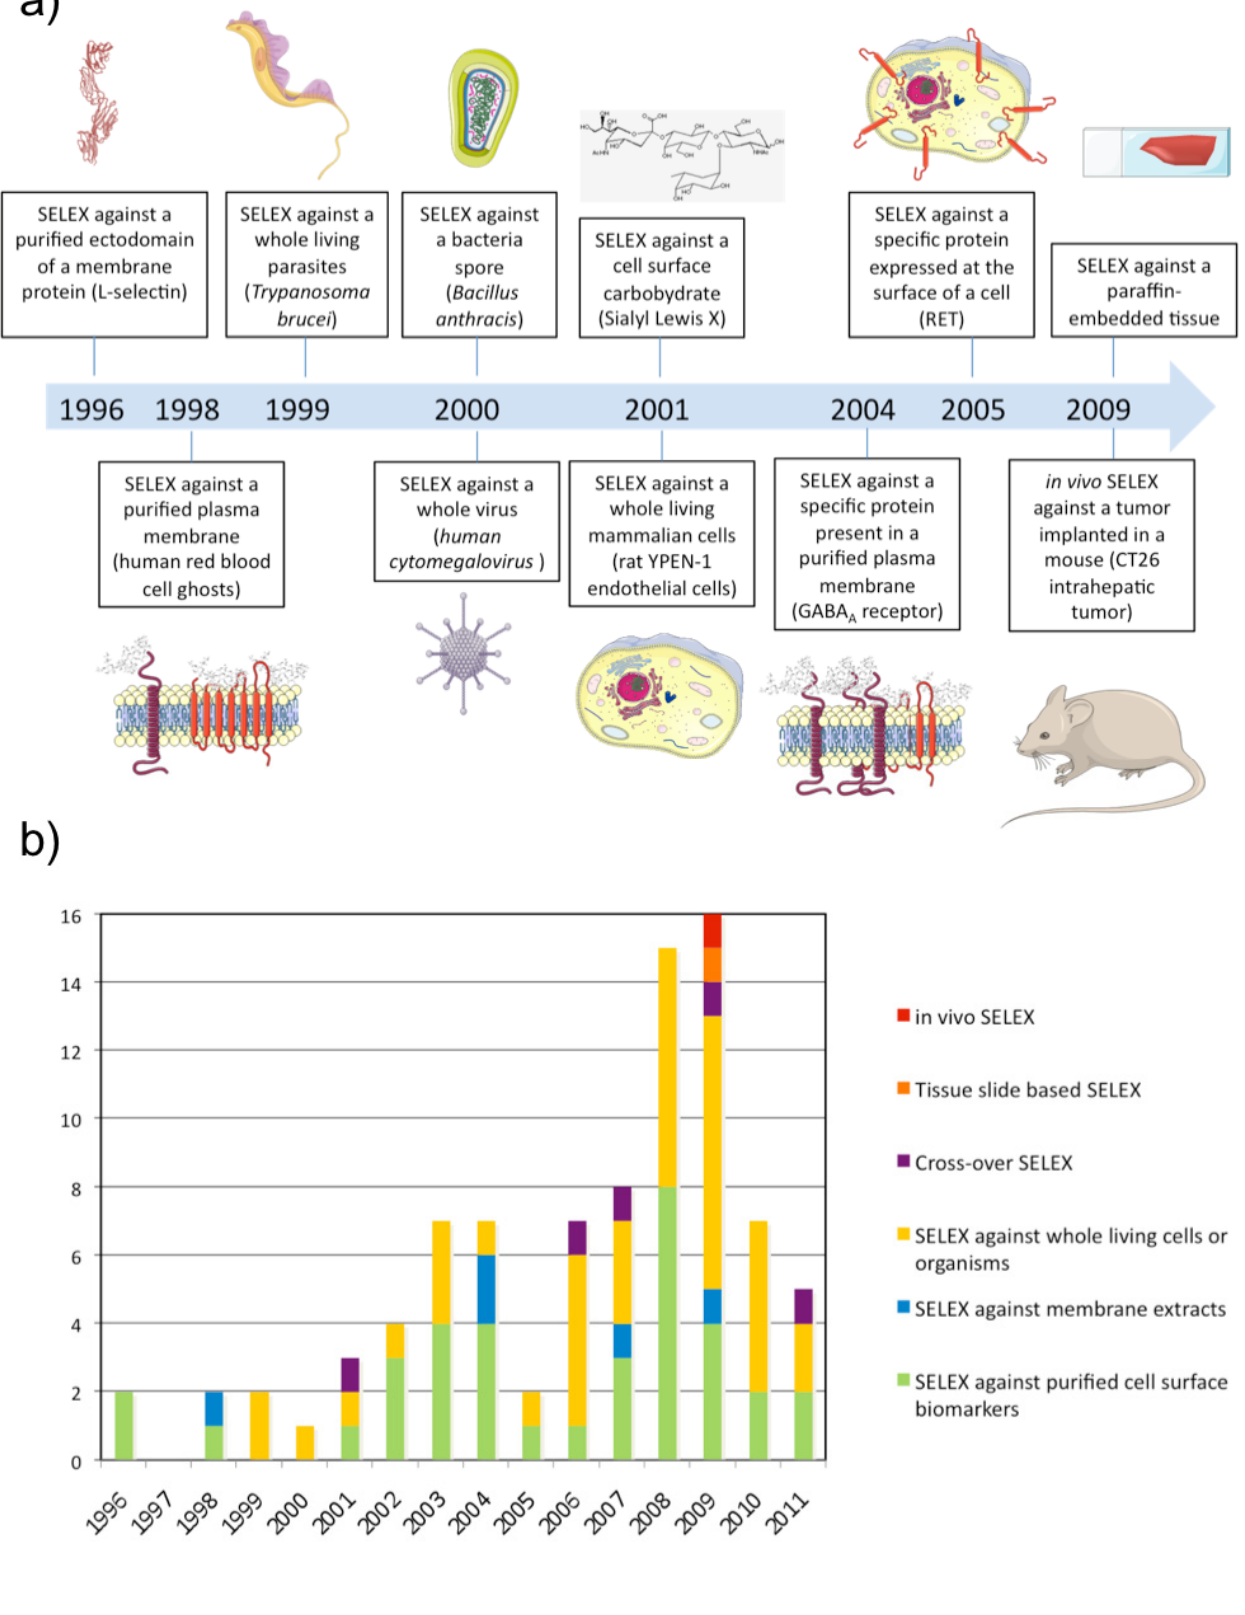
Figure 2. (a) Development of new methods of SELEX to identify aptamers against cell surface biomarkers. (b) The use of different SELEX strategies over